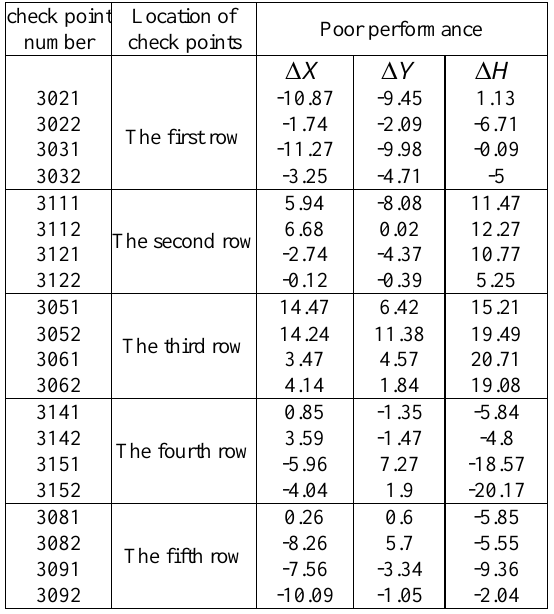
Figure 5. Distribution of ground control points and Three-Line- Array images of TH01-02 in Beijing calibration fields